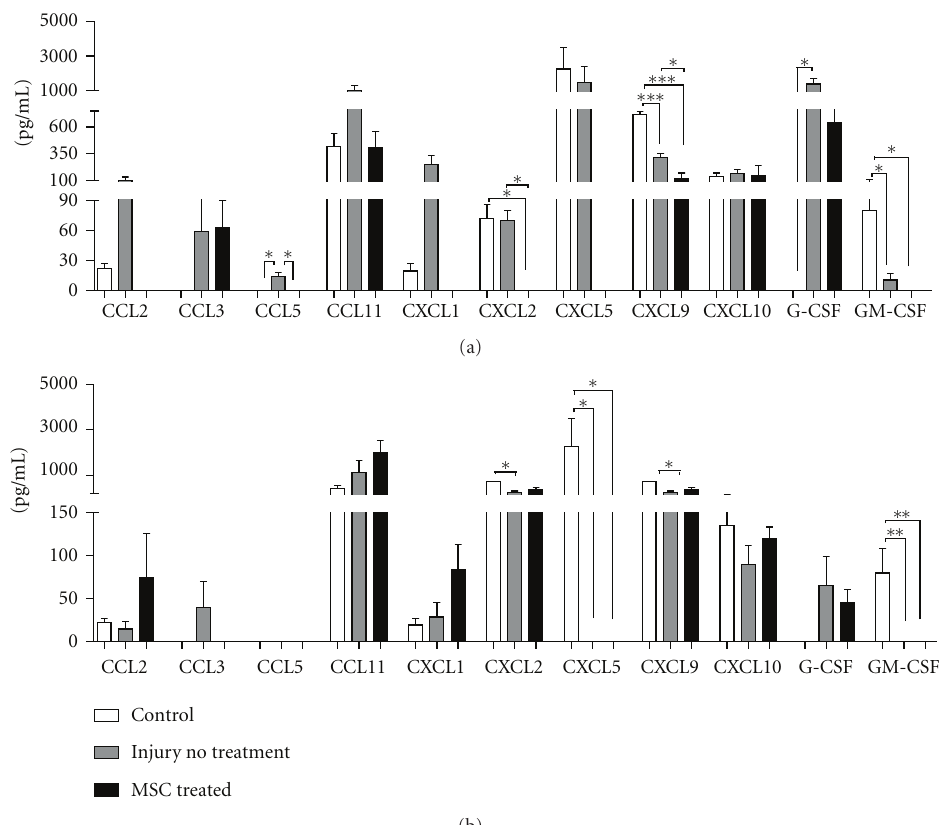
Figure 3: Chemokine profile in serum in TBI acute and chronic phase. Serum from mice submitted to the TBI protocol was used to investigate for cytokines content. Mice were transplanted (MSC treated) or not (injury not treated) with MSC immediately after the injury and blood was collected after 24 hours (acute phase) (a) or 30 days (chronic phase) (b). (control n = 3, injury no treatment n = 6, MSC treated n = 4). ∗ P < . 005, ∗∗∗ P < .